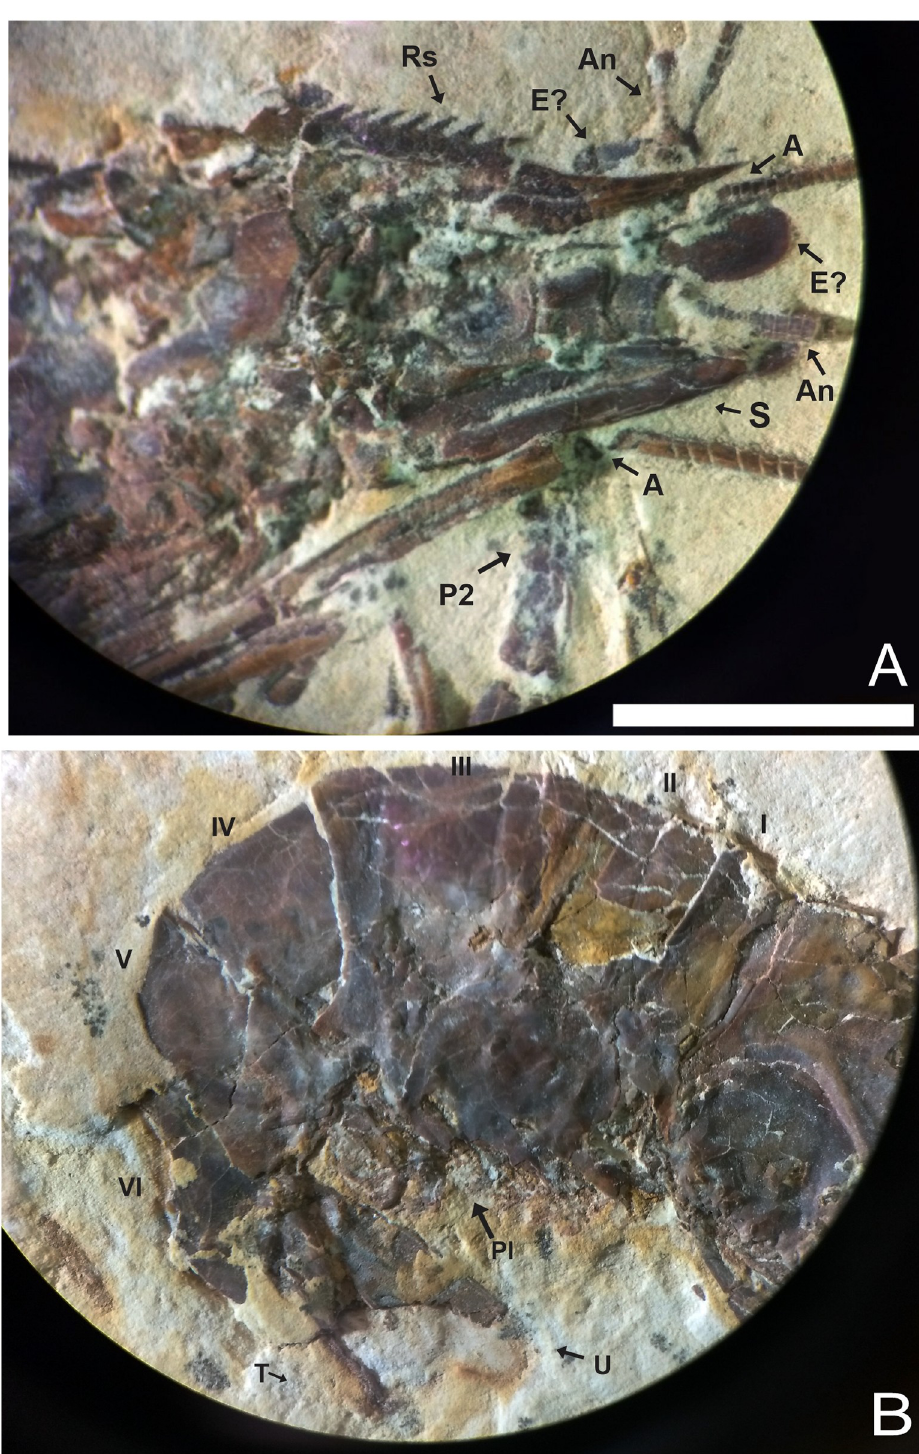
Fig 11. UFRJ 171/CR. A) The detail of the rostrum partially preserved show 9 supra-rostral spines with serrate appearance, and 2 sub-rostral spines clearly visible. B) Smooth pleon without spines, the pleura of the second somite is strongly rounded, overlapping the first and third. The fourth and fifth somites are with a strongly acute pleura, characteristic that typical of Beurlenia araripensis . Rs: Rostrum; An: Antennule; E: Eyes; A: Antenna; S: Scaphocerite; P2: Second pereopod; I-VI: Pleon; Pl: Pleopods; T: Telson; U: Uropods. Scale bar 5 mm. Photo: Olga A. Barros.